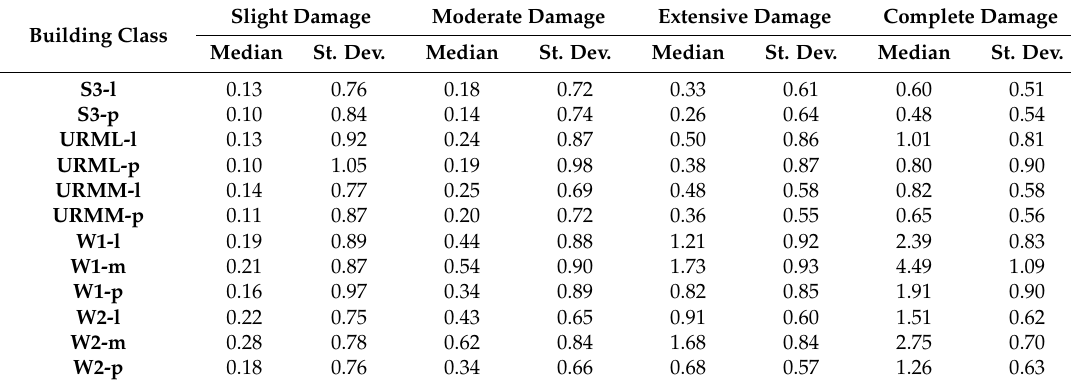
Table A5. Median and standard deviation for building classes for medium strong motion duration (5.5 < M ≤